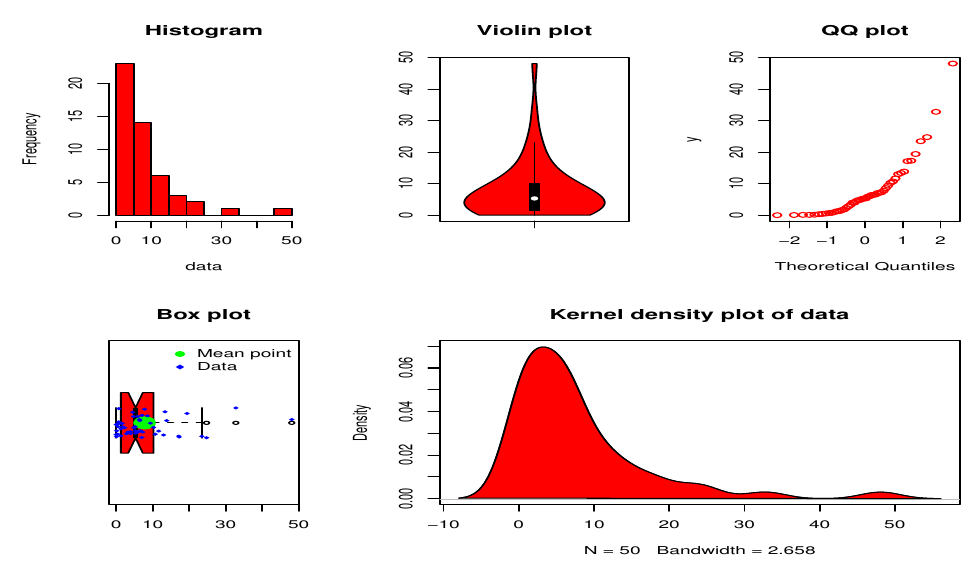
Figure 11. Visual description of the failure times data set.